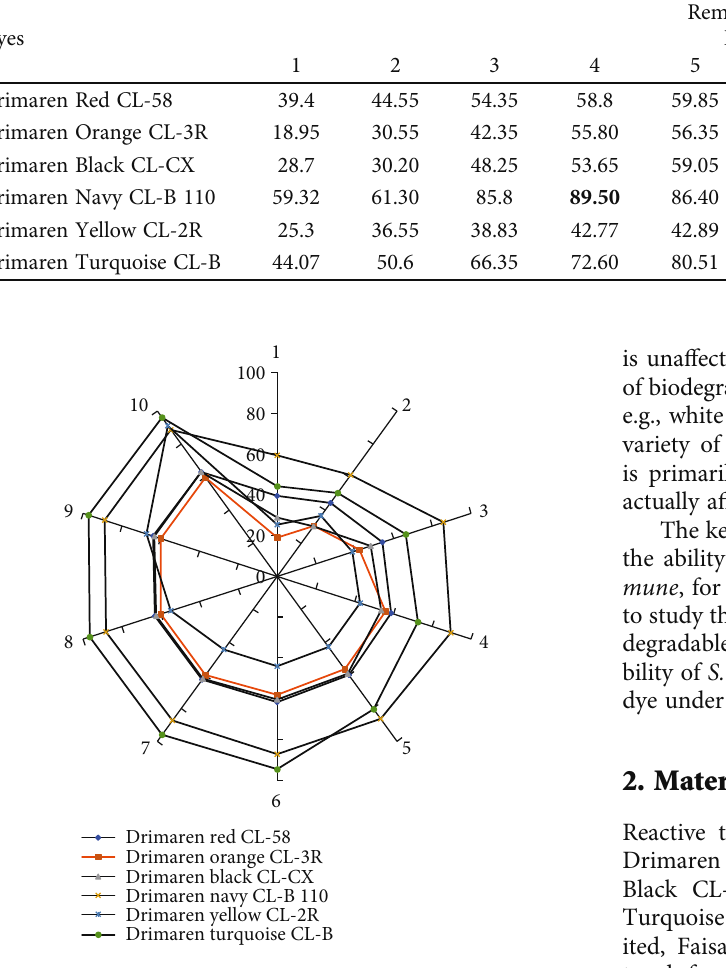
Figure 1: Removal of reactive dyes using Schizophyllum commune